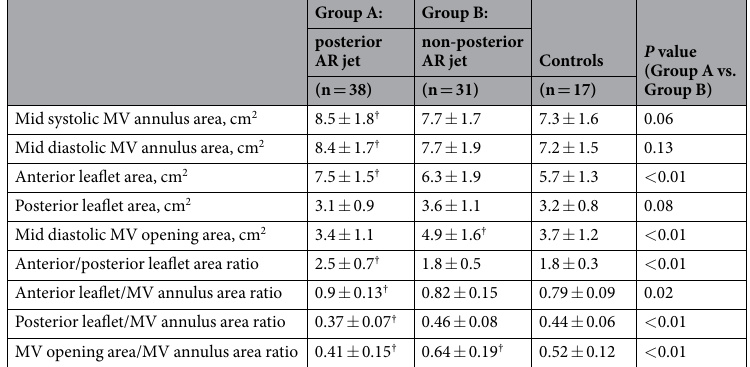
Table 3. Mitral apparatus quantification using three-dimensional transesophageal echocardiography. Values are mean ± SD or n (%). † P < 0.05 vs. controls. AR, aortic regurgitation; MV, mitral